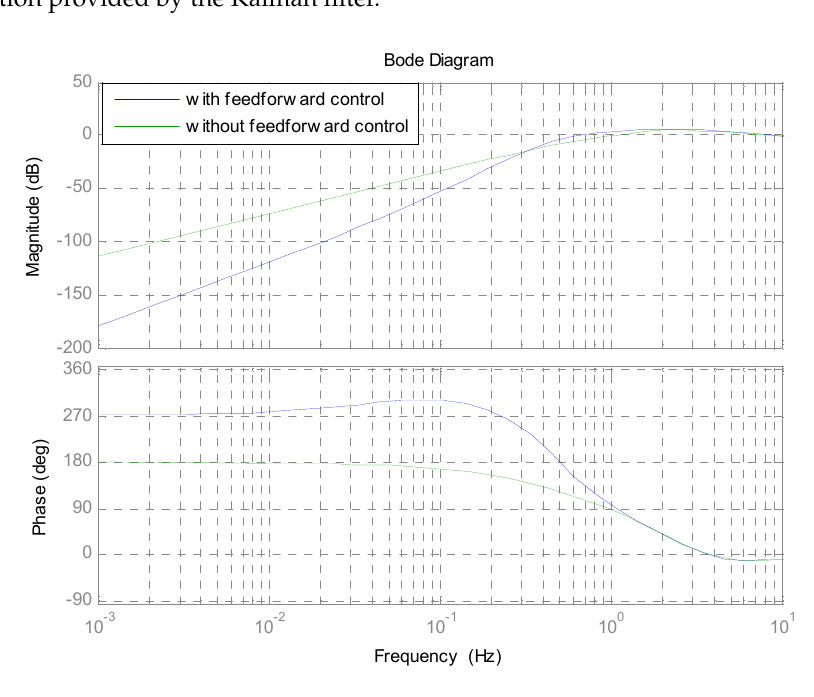
Figure 6. The sensitivity function response.